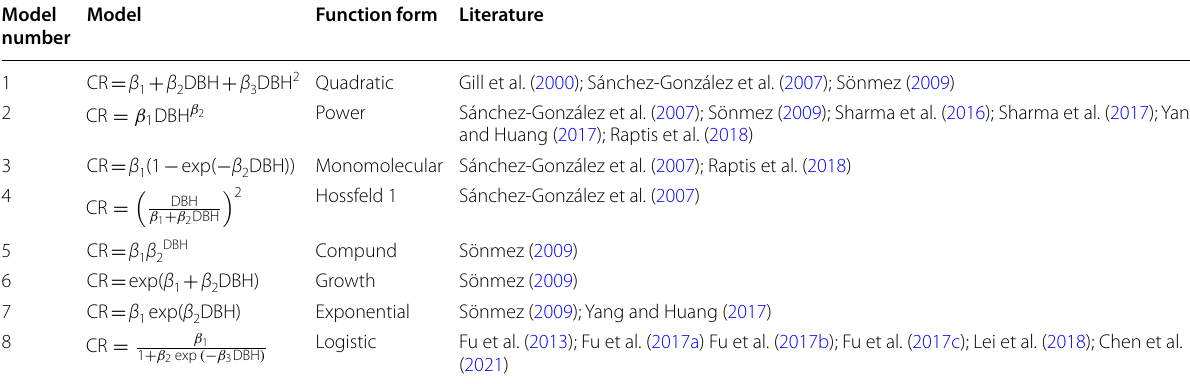
Note : CR Crown radii including CRE (eastern crown radius), CRS (southern crown radius), CRW (western crown radius), and CRN (northern crown radius) for larch, = birch, and poplar, DBH over-bark diameter at breast height, β 1 , β 2 , and β 3 are model parameters = Table 2 Descriptive statistics of the tree size and competition variables of larch, birch, and poplar